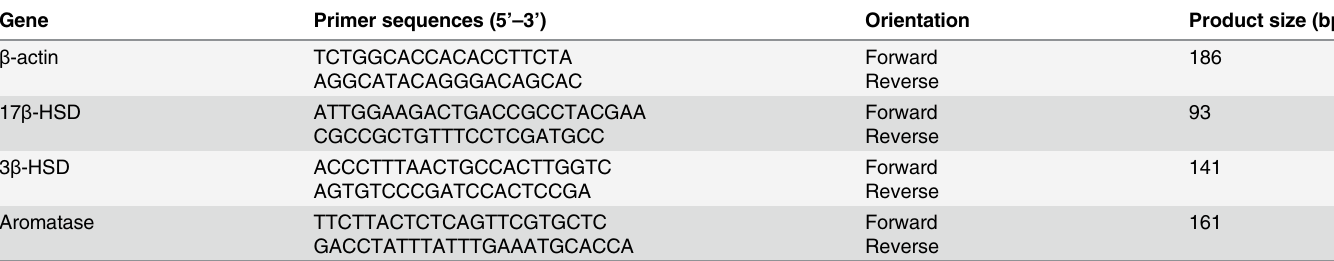
Table 2. Prime sequence of targeted gene and β